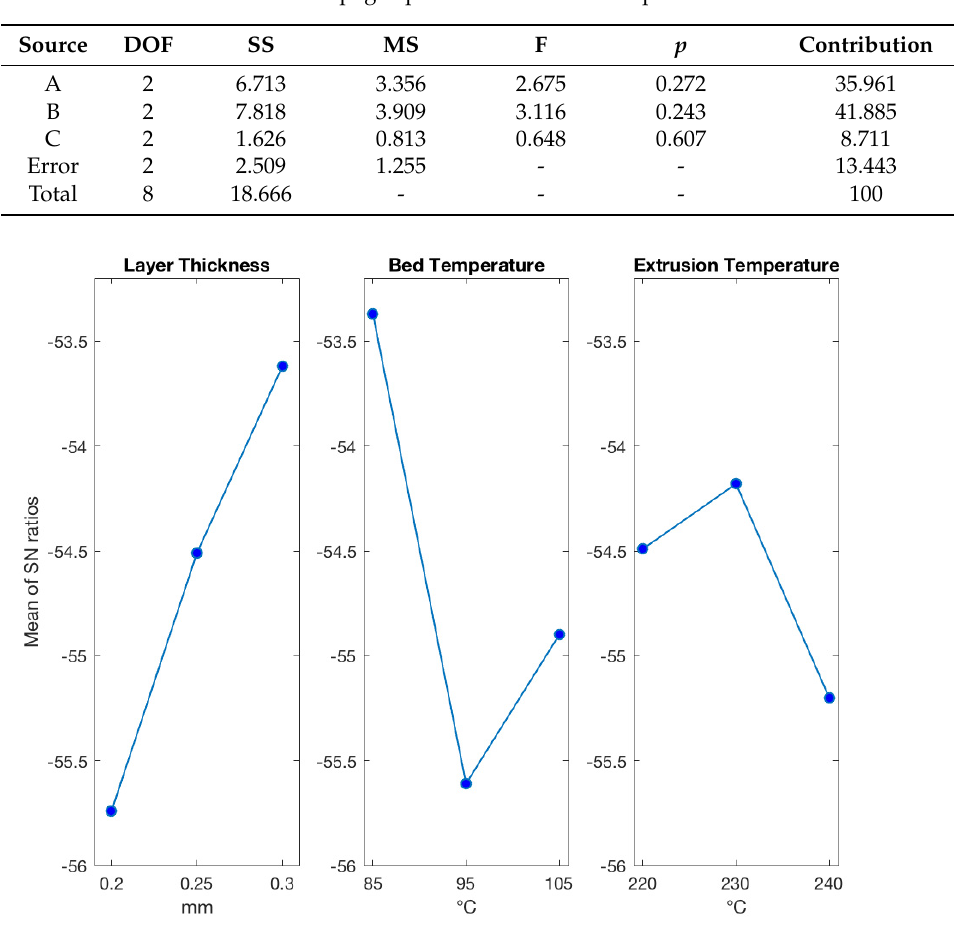
Figure 11. Experimentally derived results for warpage. Taguchi optimization of warpage deviations using FEM results are shown for min- imum warpage when levels of input parameters are as follows, 3, 2, and 3 (Figure 12). The p -values from ANOVA analyses were 0.042, 0.419, 0.343 for layer thickness,